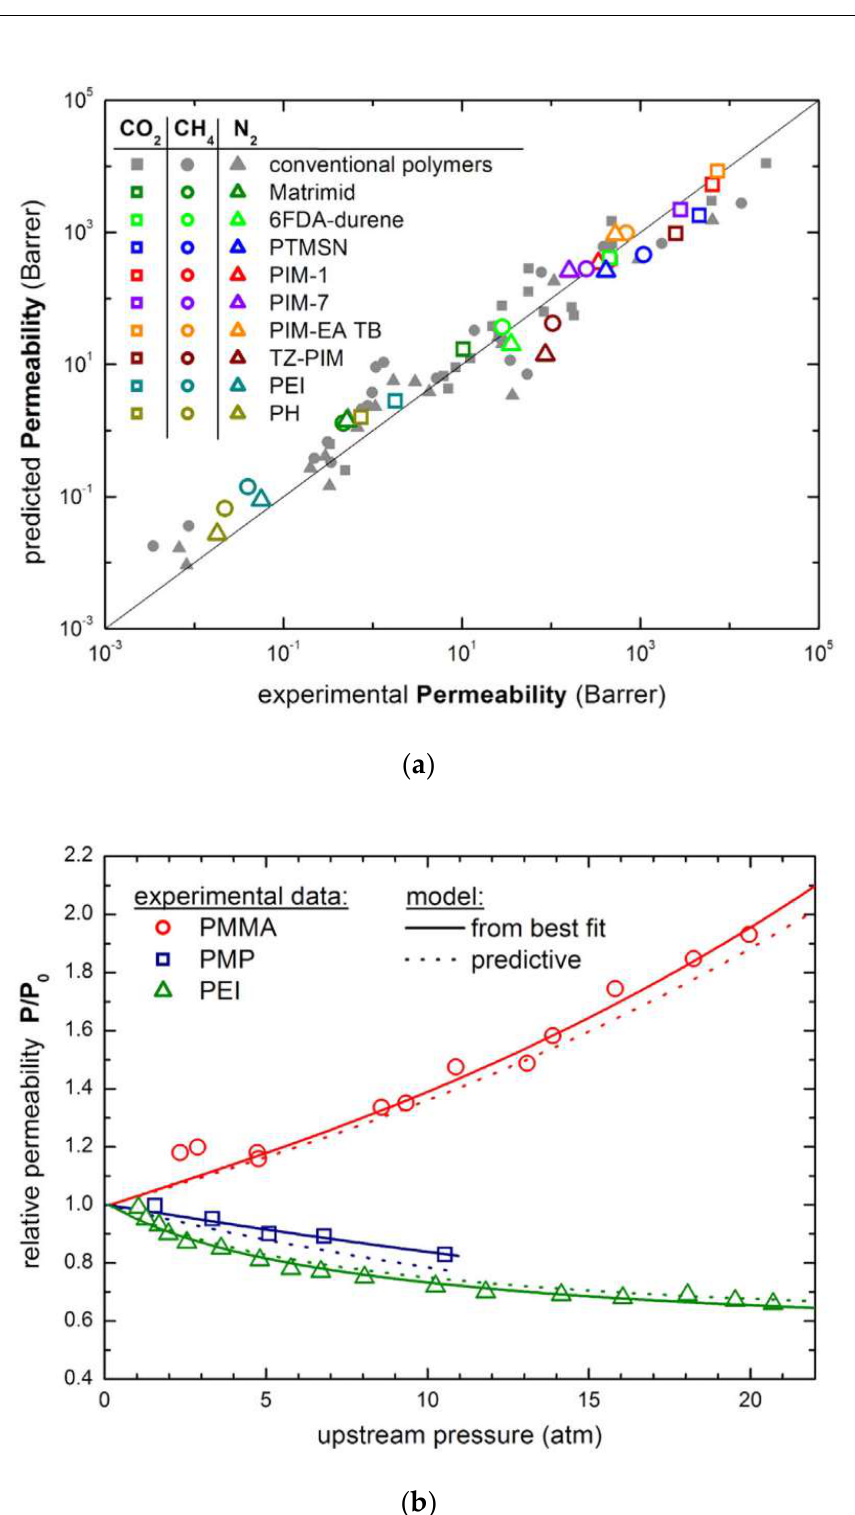
Figure 12. ( a ) Comparison of experimental gas permeability values at 35 ◦ C as predicted by the model ( k 12 = 0) considering CO 2 , CH 4 , and N 2 as penetrants in various polymeric systems not considered in the development of the correlation expressed by Equation (74). ( b ) Normalized permeability of CO 2 at various upstream pressures in glassy polymer membranes: experimental data and model calculations fitting plasticization factor in the whole curve or from a priori estimation according to Equation (74). Reproduced with permission from Ref. [231]. Copyright 2017,